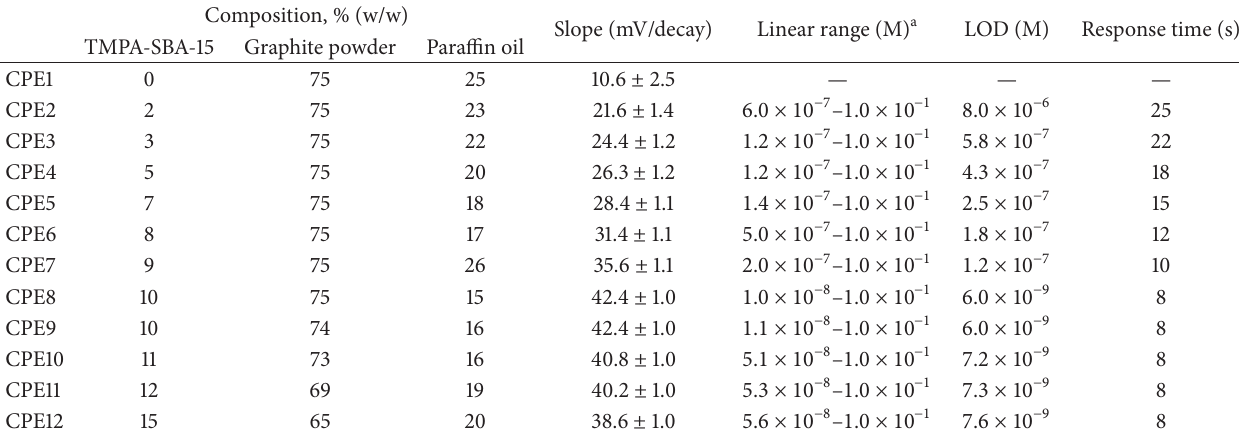
Table 1: Effect of electrode components on response characters of modified carbon paste